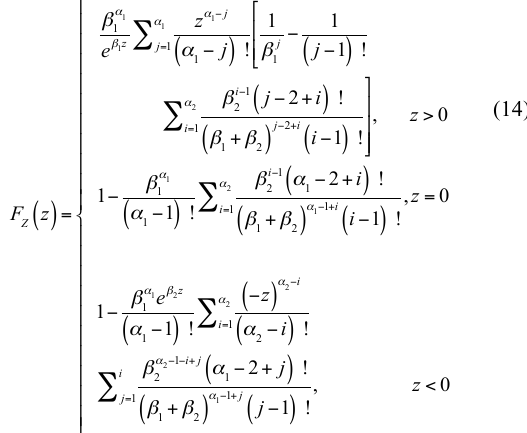
variogram of the mixture model will be calculated as follows.